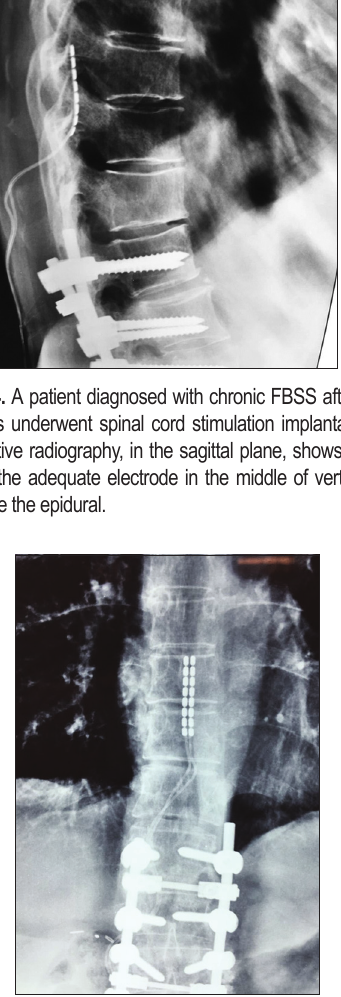
FIGURE 5. A patient affected by chronic FBSS after lumbar arthrodesis underwent SCS system implantation. The intraopera- tive radiography, in the sagittal plane, shows the positioning of the adequate electrode in the middle of the vertebral column, inside the epidural.